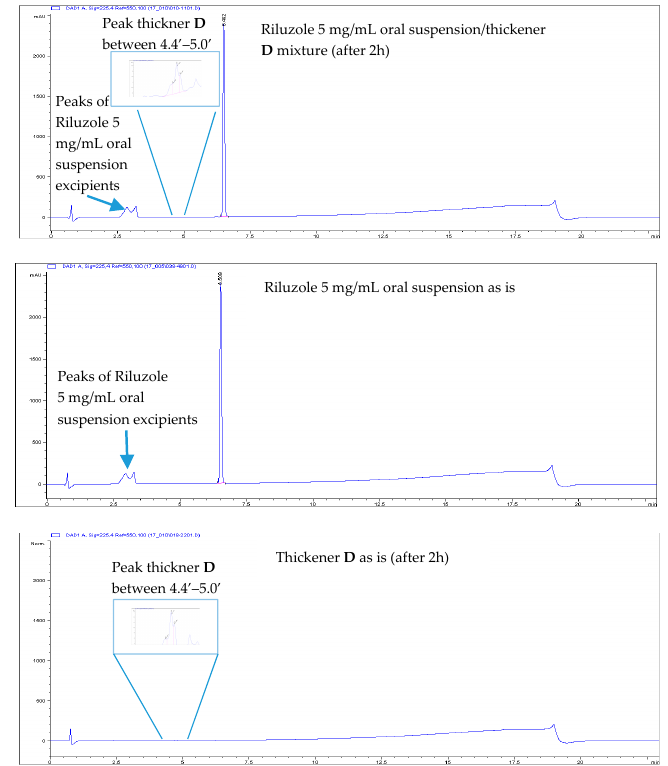
Figure 4 Figure 4. Comparison of chromatograms: Riluzole 5 mg / mL oral suspension / thickener D mixture (after 2 h); Riluzole 5 mg / mL oral suspension as is and Thickener D as is (after 2 h).